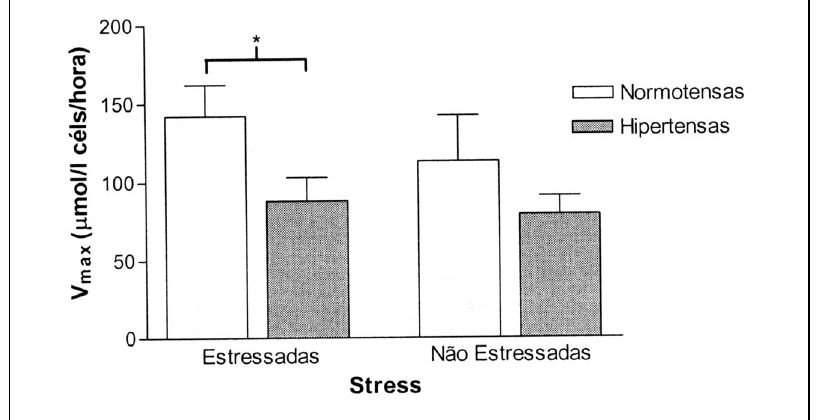
Figura 2 . Transporte celular de L-arginina em eritrócitos pelo sistema y + L em hipertensas e normotensas de acordo com o stress. Nota . * p